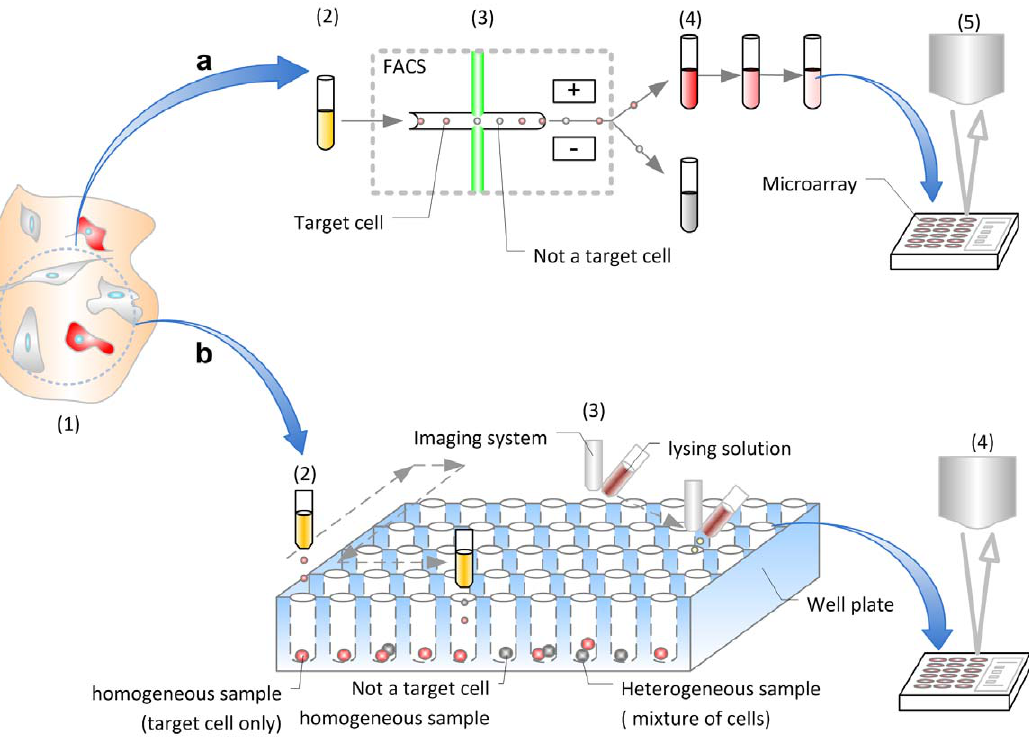
Figure 1. Description of a conventional procedure for total RNA expression analysis versus the technique described. ( a ) Conventional single cell isolation method for total RNA expression analysis. 1) Heterogeneous sample was collected from a specific tissue, macro-dissection, 2) cells were stained with a specific antibody, 3) target cells were collected with conventional FACS, 4) multiple dilution steps generated a small population of target cells, 5) total RNA gene expression analysis with microarray. ( b ) Drop-on-demand total RNA analysis approach. 1) Heterogeneous sample was collected, 2) cells were stained with antibody and patterned with cell-encapsulating droplets, 3) specific homogeneous samples containing target cells were produced by a cell droplet patterning platform; homogeneous samples were identified by an automated imaging system, 4) total RNA gene expression analysis with microarray.